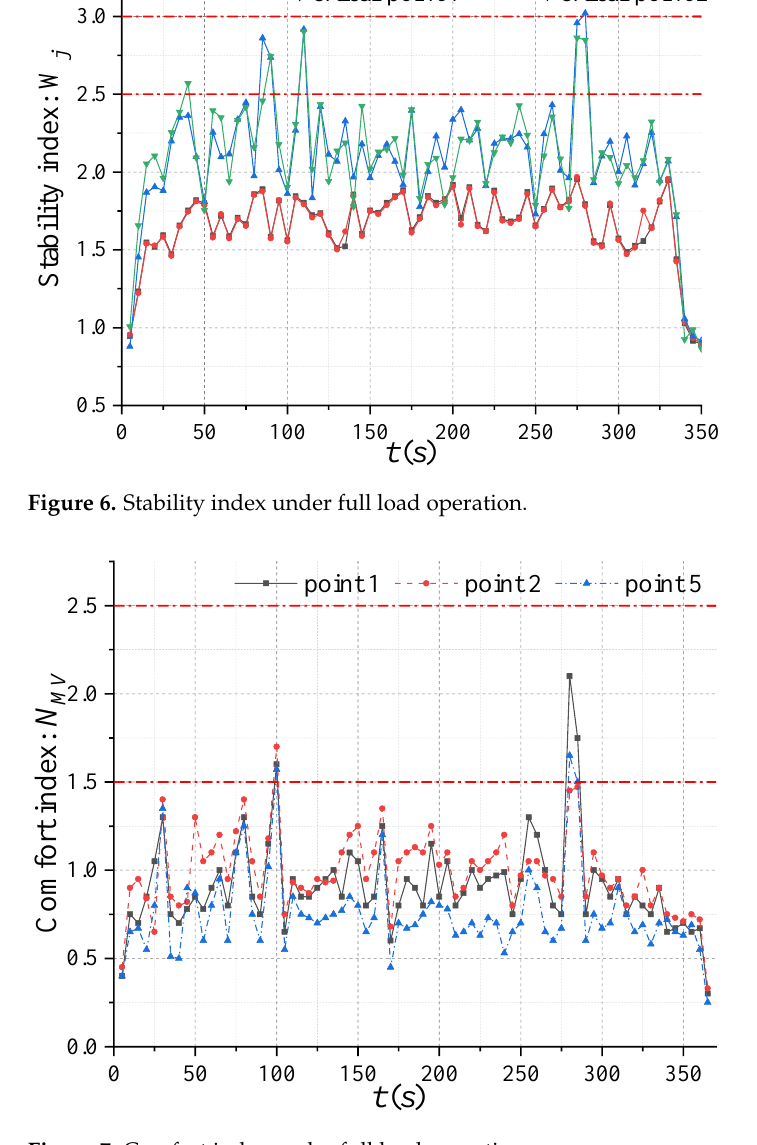
Figure 7. Comfort index under full load operation. Three people (A, B, and C) participated in the human-induced vibration test. The test conditions were divided into multi-person and multi-frequency walking to study the impact of the number of excitations and frequency on the structural response. A stopwatch timer controlled the excitation frequency. The acquisition time of each condition was 10 s. At the same time, 10-person excitation conditions were simulated. Table 2 shows the specific condition information, and the walking route is shown in Figure 3d. The field test is shown in Figure 8. When people generally walk on the evacuation platform, there is a slight lateral amplitude on the top of the column. The measured lateral amplitude on the top of a